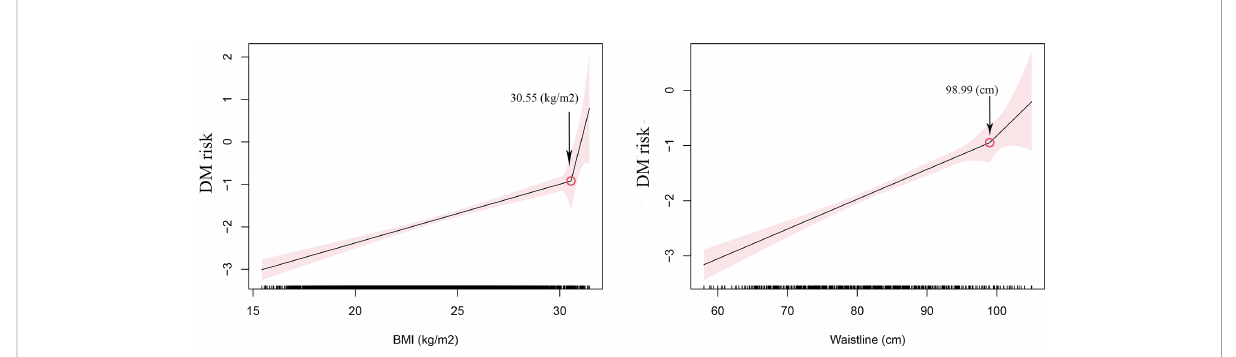
FIGURE 2 The effect of body mass index (BMI) and waist circumference (WC) on the risk of diabetes.